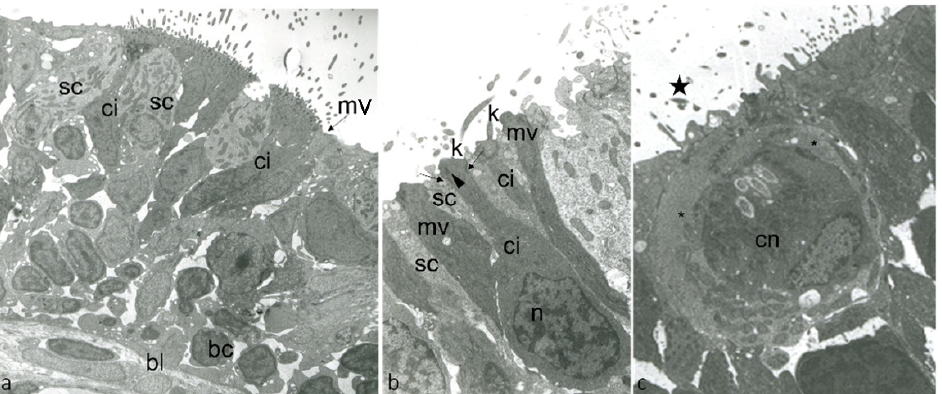
Figure 1. Transmission electron micrographs of ultrathin sections showing the surface of olfactory epithelium adult zebrafish: ( a ) ci, ONR ciliated; mv, ONR microvillous; sc, supporting cells; bc, basal cells; bl, basal lamina. ( b ) ci, ONR ciliated; n,“checkerboard” nucleus of ciONR; K, kinocilia ; mv, ONR microvillous; sc, supporting cells; kinocilium basal body foot (arrowhead), junctional complex with neighboring supporting cells (arrows). ( c ) cn, crypt neurons with several cilia within the crypt (star); special supporting cells